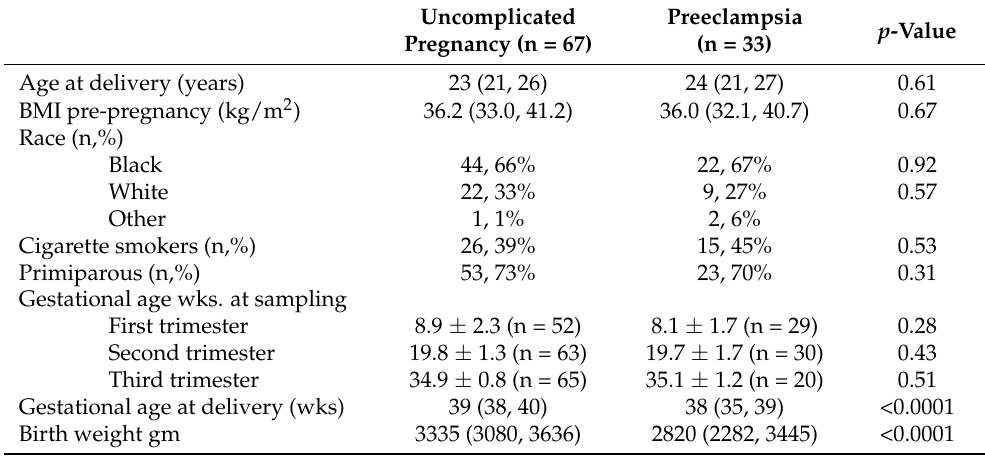
Table 1. Clinical Data of